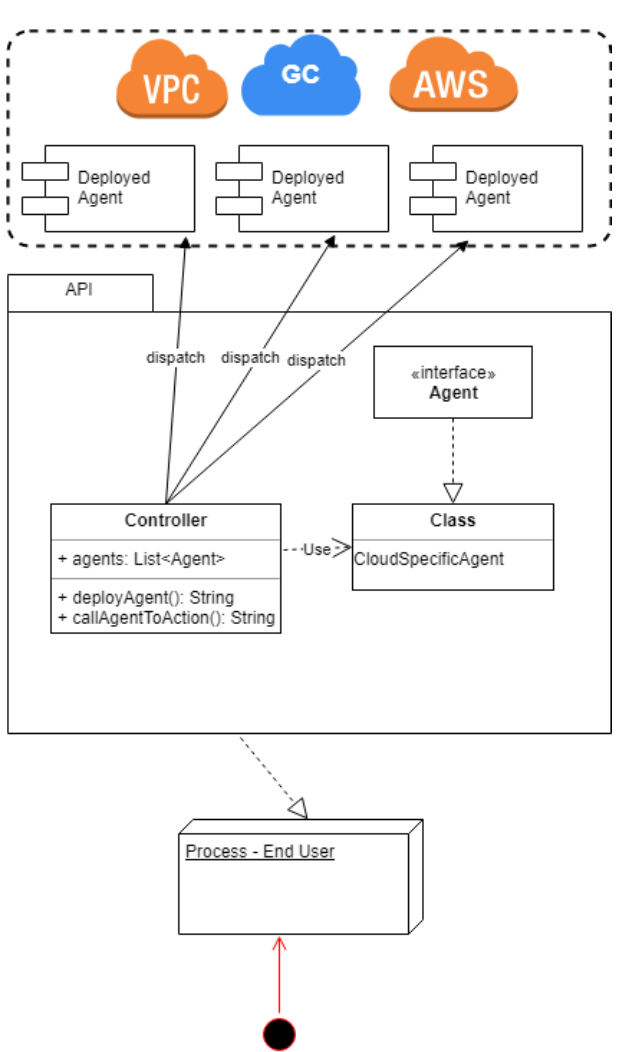
Figure 2. Resource management in the multi-cloud: simplified layered architecture.